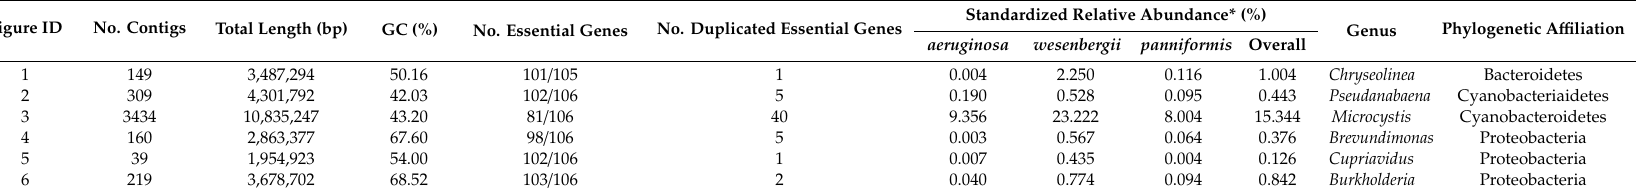
Table 2. Assembly statistics for the 6 representative